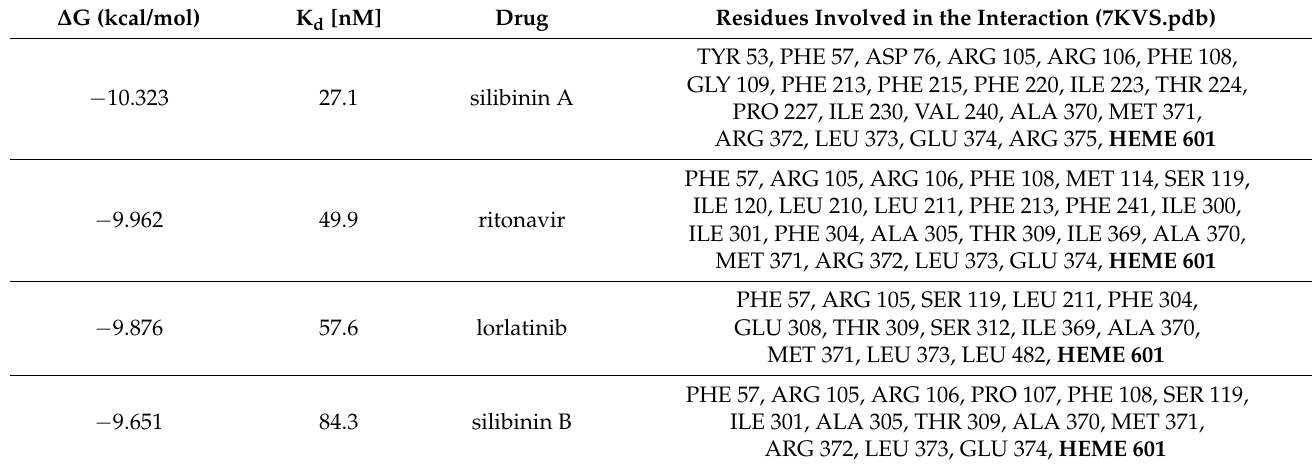
Table 2. Details of the interaction between silibinin A/B, ritonavir and lorlatinib to CYP3A4.